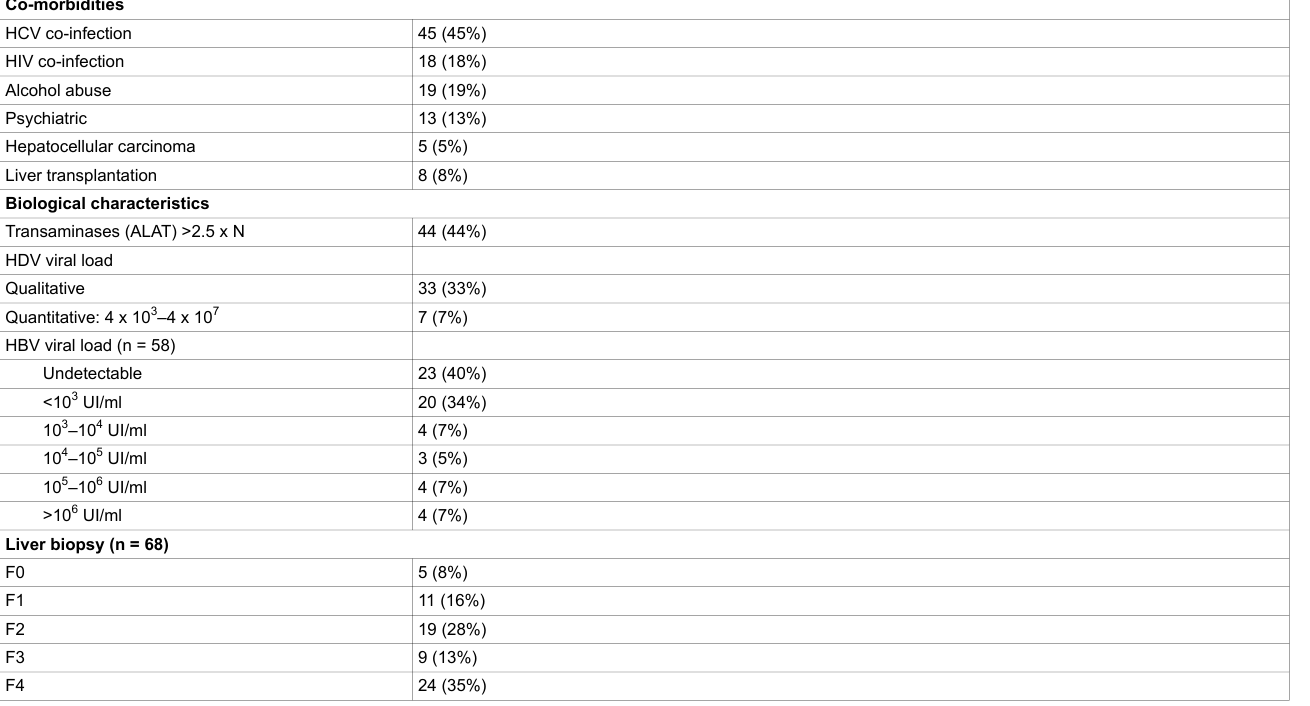
Table 1: Clinical and laboratory characteristics of patients with HDV (n = 101).